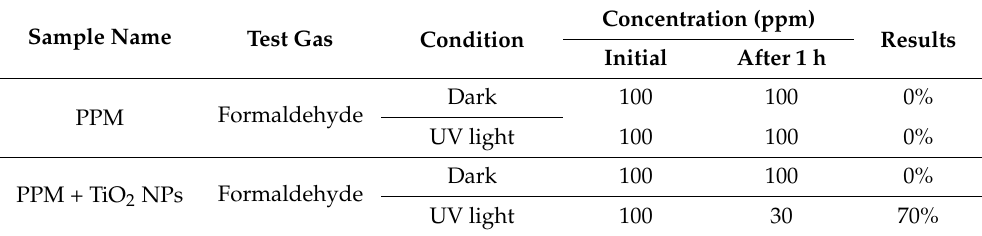
Figure 10. Thermal properties of PPM and PPM + TiO 2 NPs: ( a ) TGA, ( b ) DSC, ( c ) TMA, and ( d ) DMA. Table 1. Photocatalytic VOC degradation using the PPM + TiO 2 NP